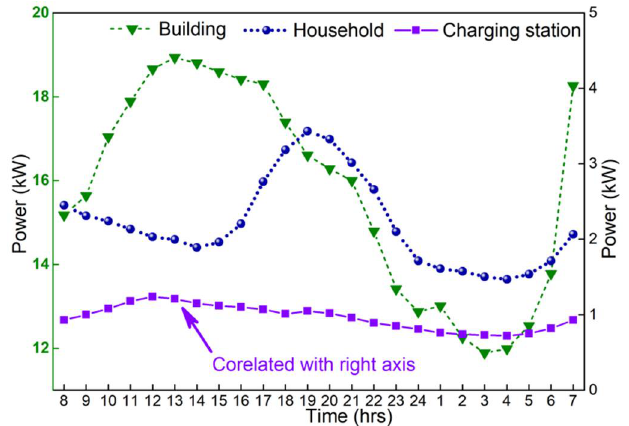
Figure 9. Basic load profiles for simulation: left axis for the building and household load; right axis for the charging station load.